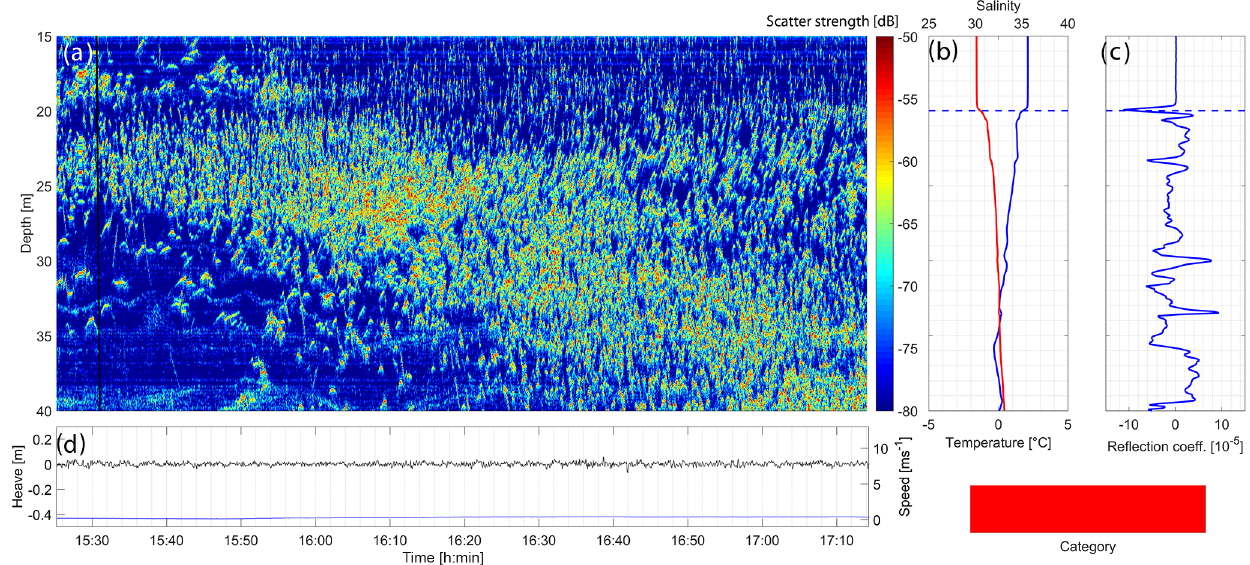
Figure 6. MLD obscured by biological scatter. Data were acquired on 15 September 2014 at 143.2 ◦ E, 79.9 ◦ N. (a) EK80 echogram with black vertical line indicating the position of the CTD rosette. (b) CTD profiles showing temperature (blue) and salinity (red). (c) Reflection coefficients derived from CTD data. The horizontal dashed line in (b) and (c) show the MLD as defined by the (cid:49)T threshold method. Also shown at the lower right is the category (red) of this particular CTD station, indicating the failure of the acoustic method to detect the MLD amidst strong biological scattering that spans across the